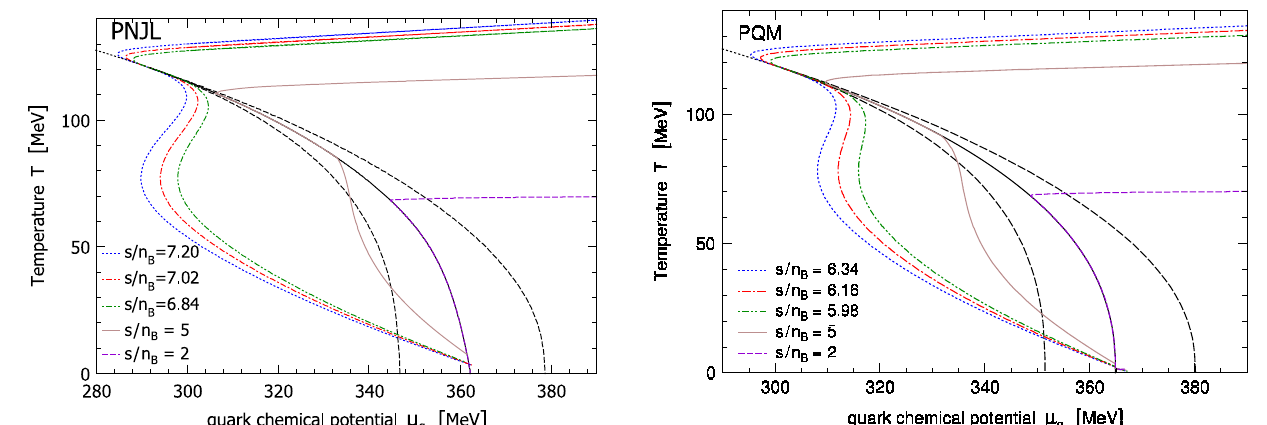
Fig. 3 Zoomofthefirst-orderregioninthephase-diagramofthePNJL (leftpanel)andPQM(rightpanel)model.Theblack,dashedlinesarethe boundary of the metastable region, in which the system can be found in alocalminimumofthethermodynamicpotential.Thebrownandpurple